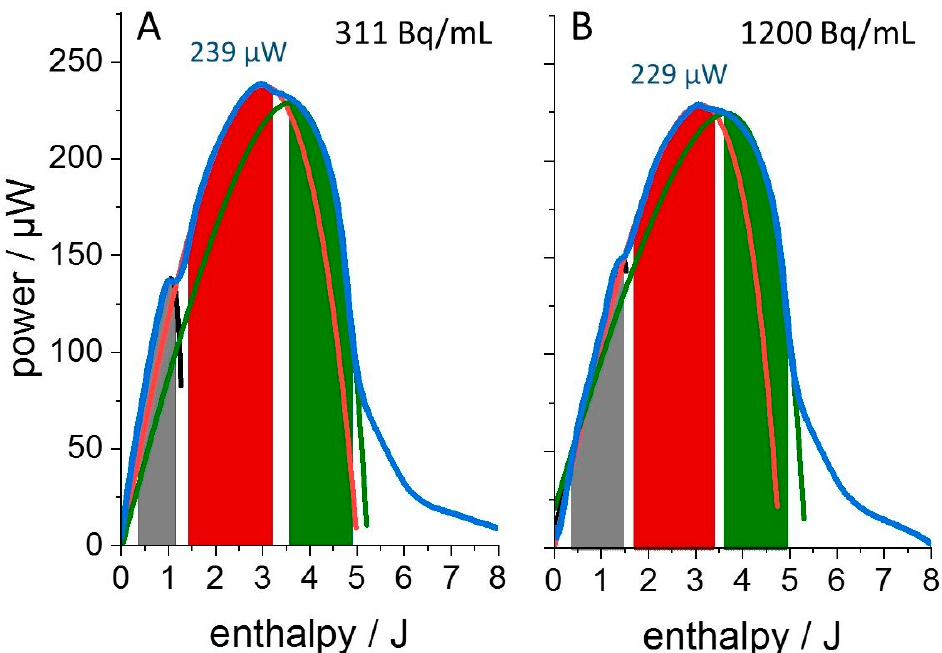
Figure 3. “Enthalpy plots” of thermograms from L. lactis cultures grown in the presence of the radioactive isotope 152 Eu. The total concentration of EuCl 3 in the growth medium was 100 µM supplemented with ( A ) 320 pM 152 Eu, (311 Bq/mL) or ( B ) 1230 pM 152 Eu (1200 Bq/mL). See Figure S1 for more thermograms recorded in the presence of 152 Eu. Concentrations are rounded to the closest multiple of 10 pM. Color code as in legend to Figure 2.